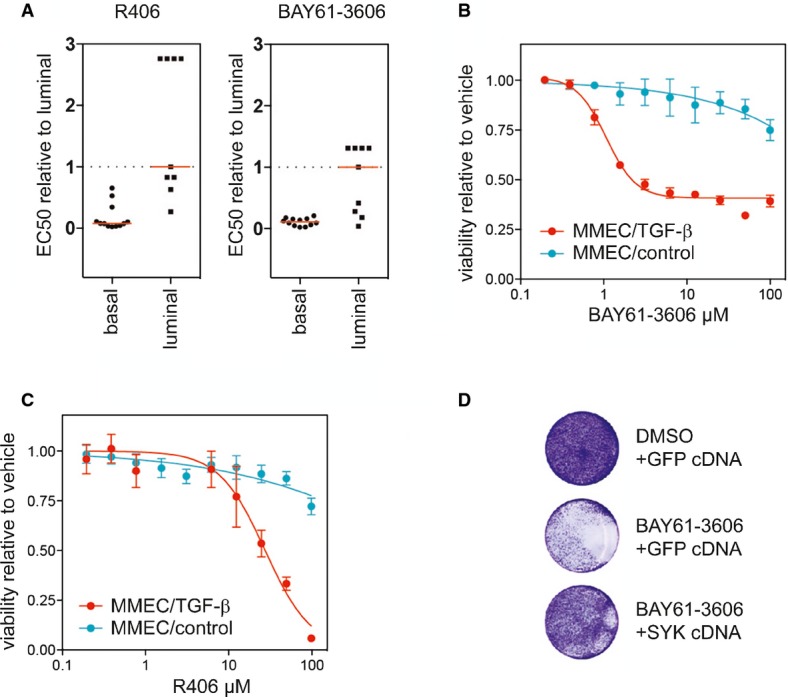
SYK kinase activity is specifically required in basal-like breast cancer cell lines
A Cell line panel of basal-like (n = 9) and luminal cells (n = 10) treated with two SYK inhibitors. P < 0.0001 for R406 and P < 0.01 for BAY61-6306, Mann–Whitney U-test.

B Dose–response experiment with the SYK inhibitor BAY61-3606 on TGF-β- or vehicle-treated MMEC-HRASV12G cells. Data are expressed as mean ± SD, n = 3.

C Cells as in (B) treated with the SYK inhibitor R406. Data are expressed as mean ± SD, n = 3.

D MDA-MB-468 transfected with a SYK cDNA or GFP-expressing vector were treated with 10 μM BAY61-3606 for 7 days. Cells were visualized using crystal violet.